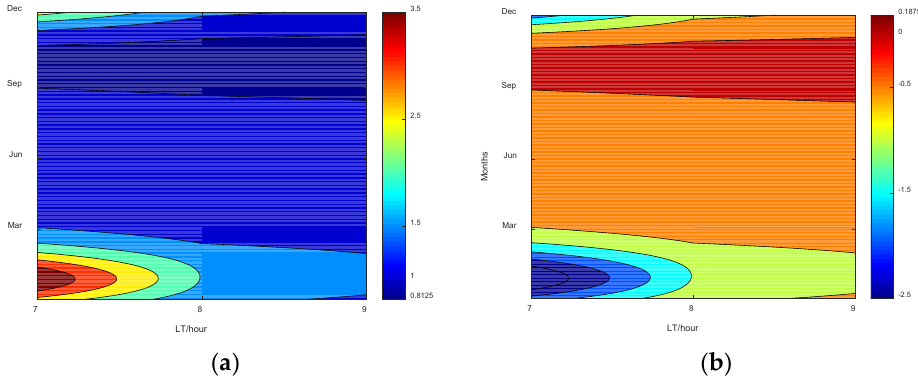
Figure 8. ( a ) The ratio of vertical drift velocity difference ∆ ( − sin I cos I ∗ U sin D ) caused by zonal